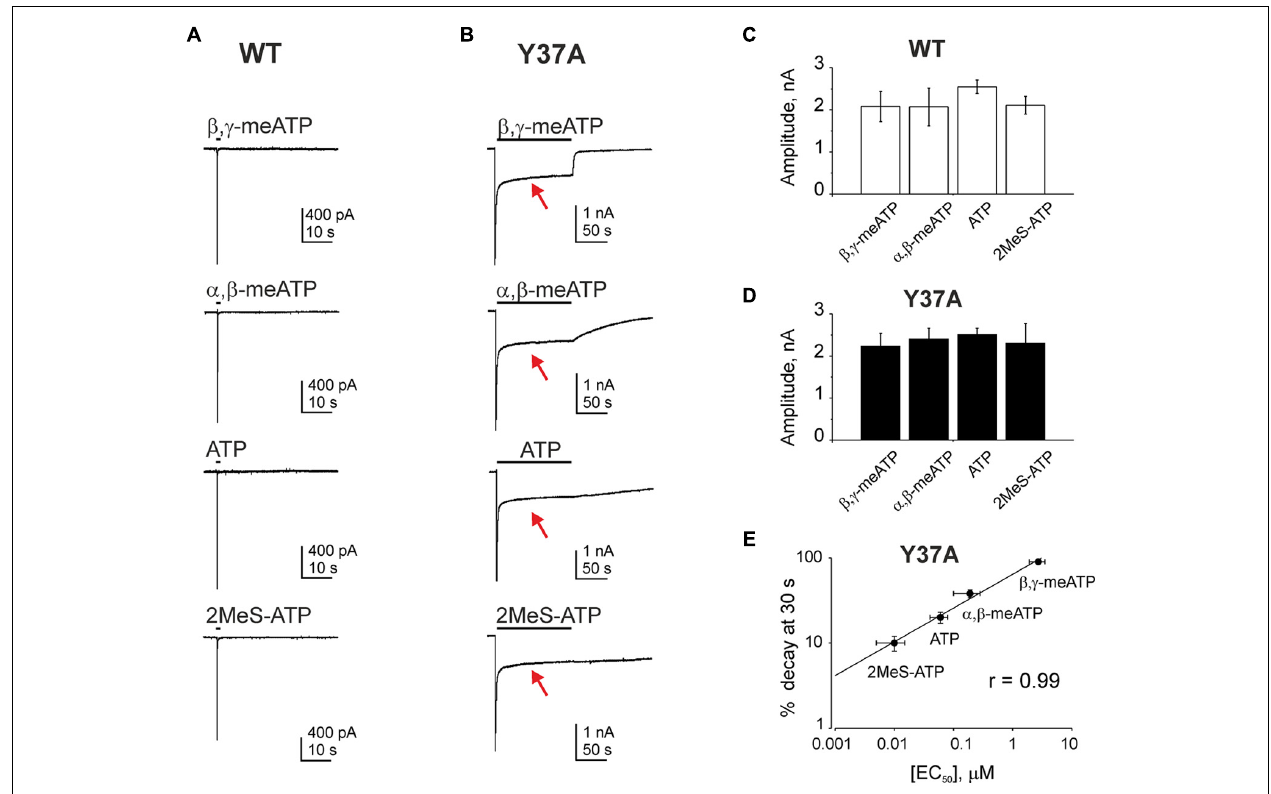
FIGURE 2 |The action of different agonists on the WT and Y37A receptor. (A) Currents activated by 2 s application of β , γ -meATP, α , β -meATP, ATP, or 2MeS-ATP (all 100 μ M) on WT receptors. (B) Currents activated by 2 min application of β , γ -meATP, α , β -meATP, ATP, or 2MeS-ATP (in keeping with higher potency, all at 10 μ M) on Y37A mutant receptors. Note similar peak amplitudes and plateau-like components (red arrows) but different current decays during the washout